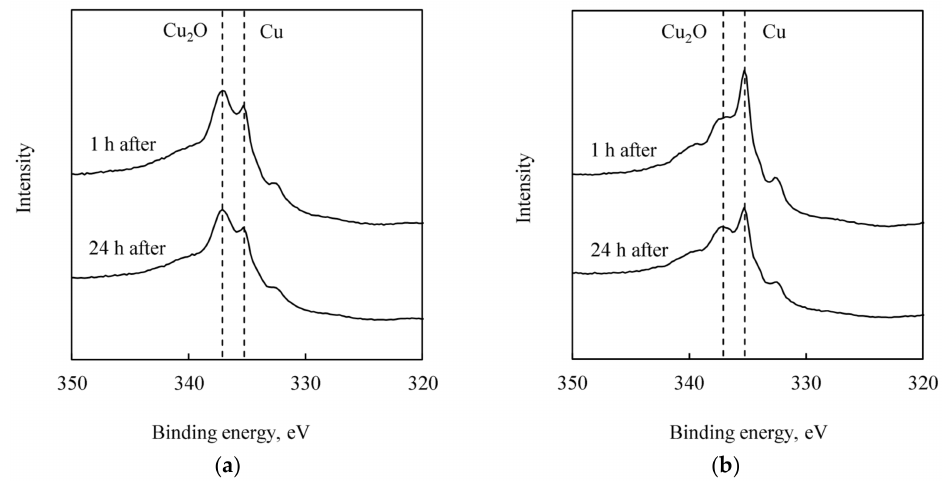
Figure 9. AES spectra of the treated Cu films after exposed to the air for 1 or 24 h. ( a ) Citric acid treated Cu film. ( b ) Atomic hydrogen treated Cu